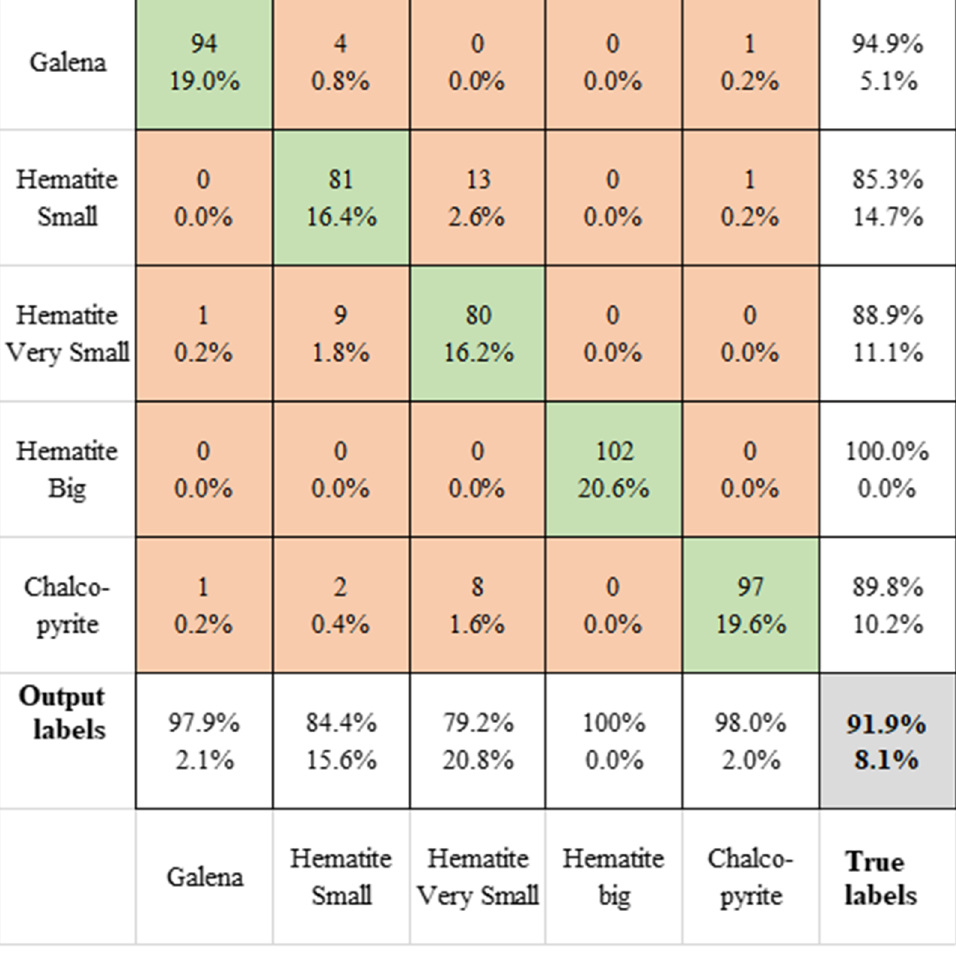
Figure 16. The learning curve of deep learning for five types of minerals. (The horizontal axis shows the iteration and the vertical axis shows the accuracy of classification. The blue line shows the accuracy for the learning data set and the black dots represent the accuracy for the verification data set.).